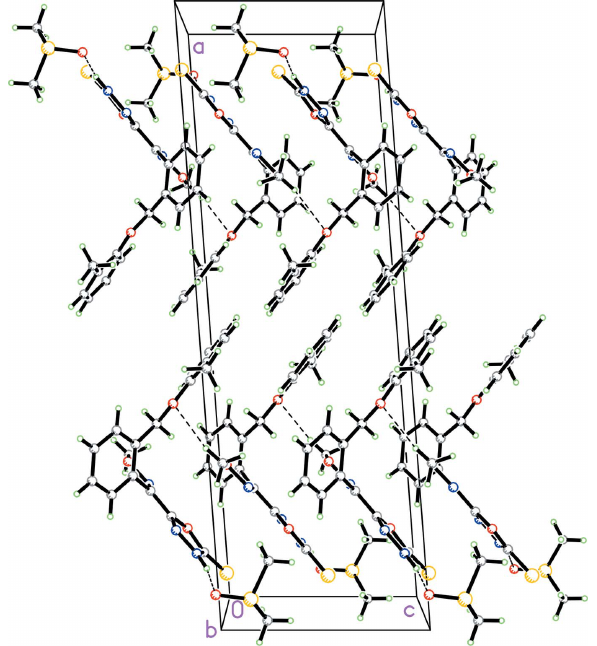
Figure 2 Diagram showing the packing of 1 with hydrogen bonds shown as dashed lines. The molecules of 1 are linked by C—H (cid:2)(cid:2)(cid:2) O interactions forming a C 1 (9) chain propagating in the c -axis direction. 1